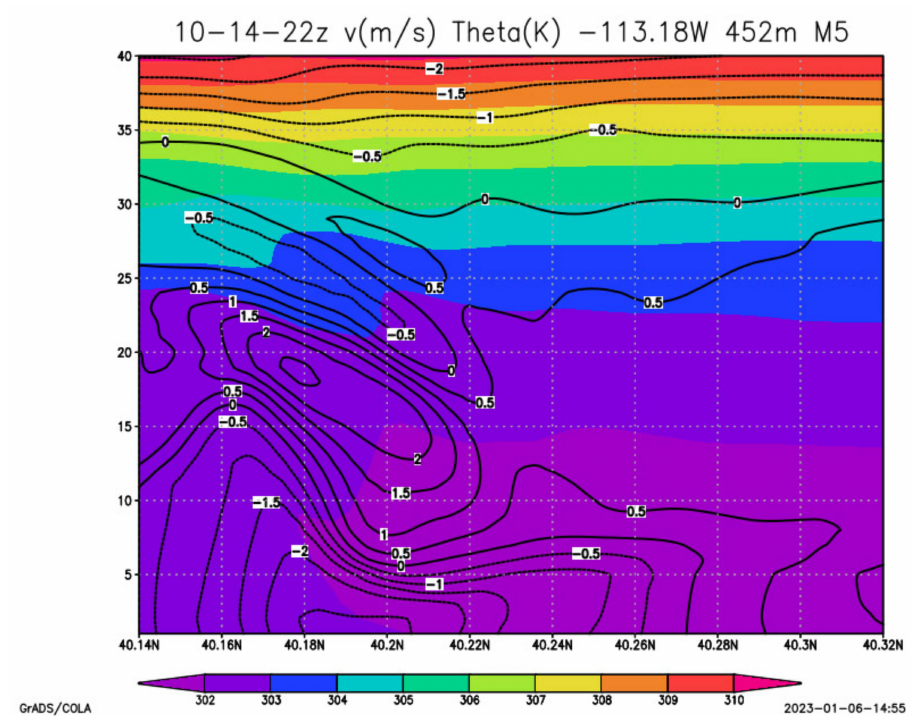
Figure 24. Model MS5 shaded “theta” ( ◦ K) and black contours of v-wind component (m/s) for the cross section along − 113.18 W shown in the previous Figure 23. Vertical units are half-sigma levels, with level 20 at 749 m AGL, level 30 at 1330 m AGL, and level 40 at 2246 m AGL.